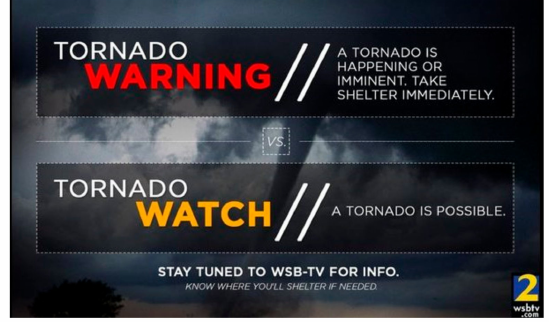
Figure 16. Tornado watch or a tornado warning on TV